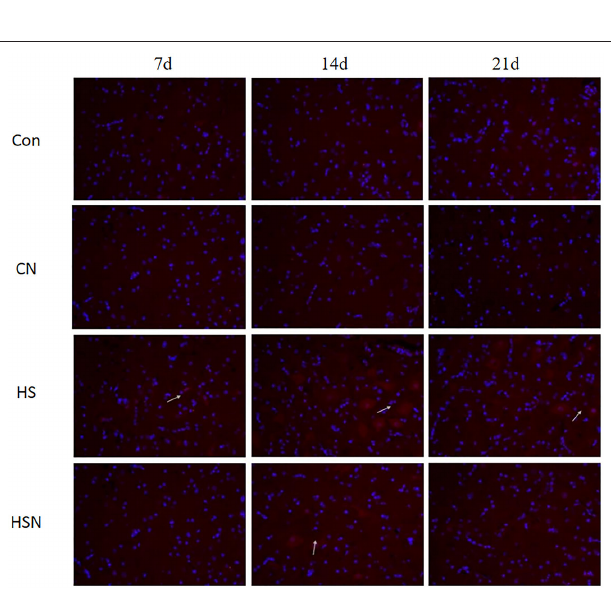
FIGURE 5 | Effect of heat stress and NAC on protein levels of AMPK in the hypothalamus (400 × ) (the red part pointed by the arrow is the AMPK